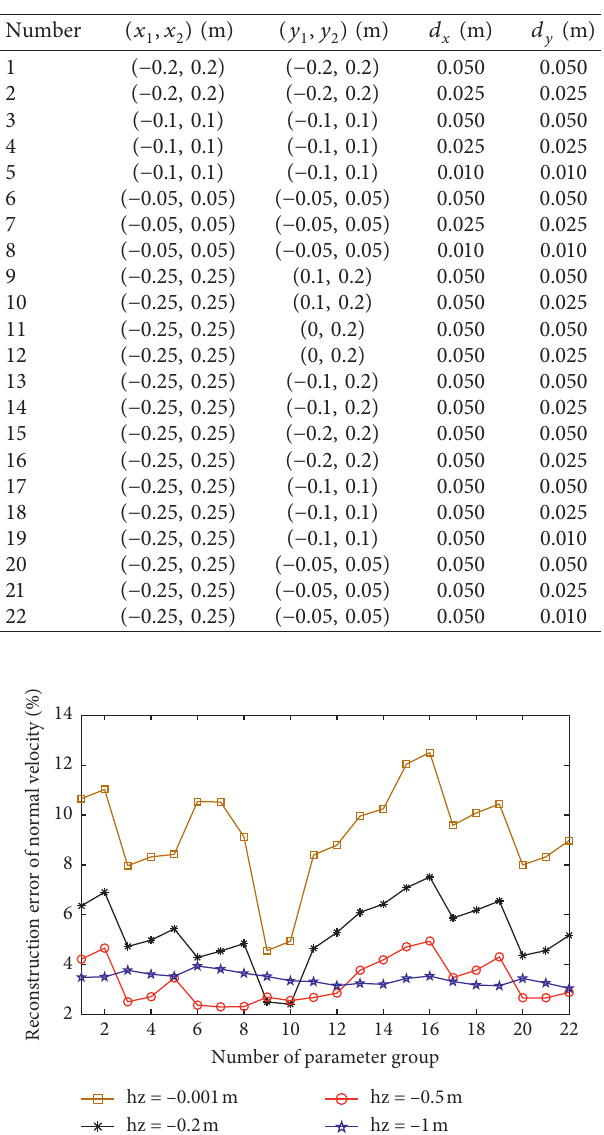
, x ,y ,y , d , d ) in numerical x y 1 2 1 2